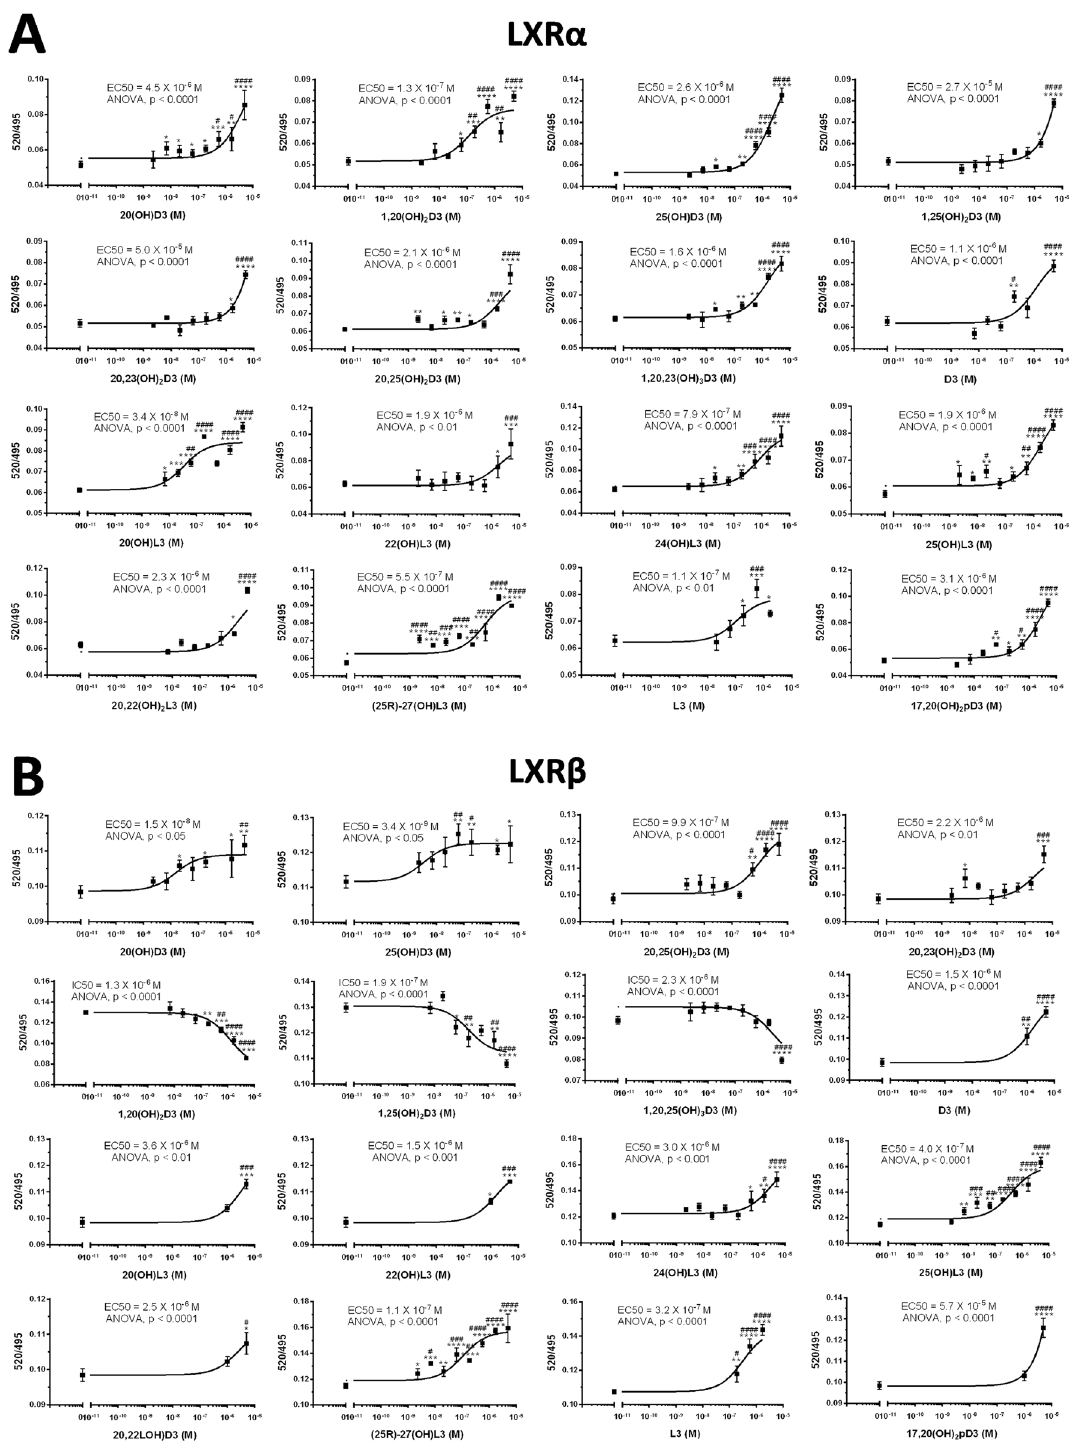
Figure 5. Binding of L3 and D3 derivatives to the LBD of the LXRα ( A ) and β ( B ) in LanthaScreen TR-FRET LXRα and β coactivator assays. ( A ) and ( B ): representative binding curves with values presented as means ± SE, (n = 4). Analysis was done using one-way ANOVA with significance defined as *p < 0.05, **p < 0.01, ***p < 0.001 or ****p <